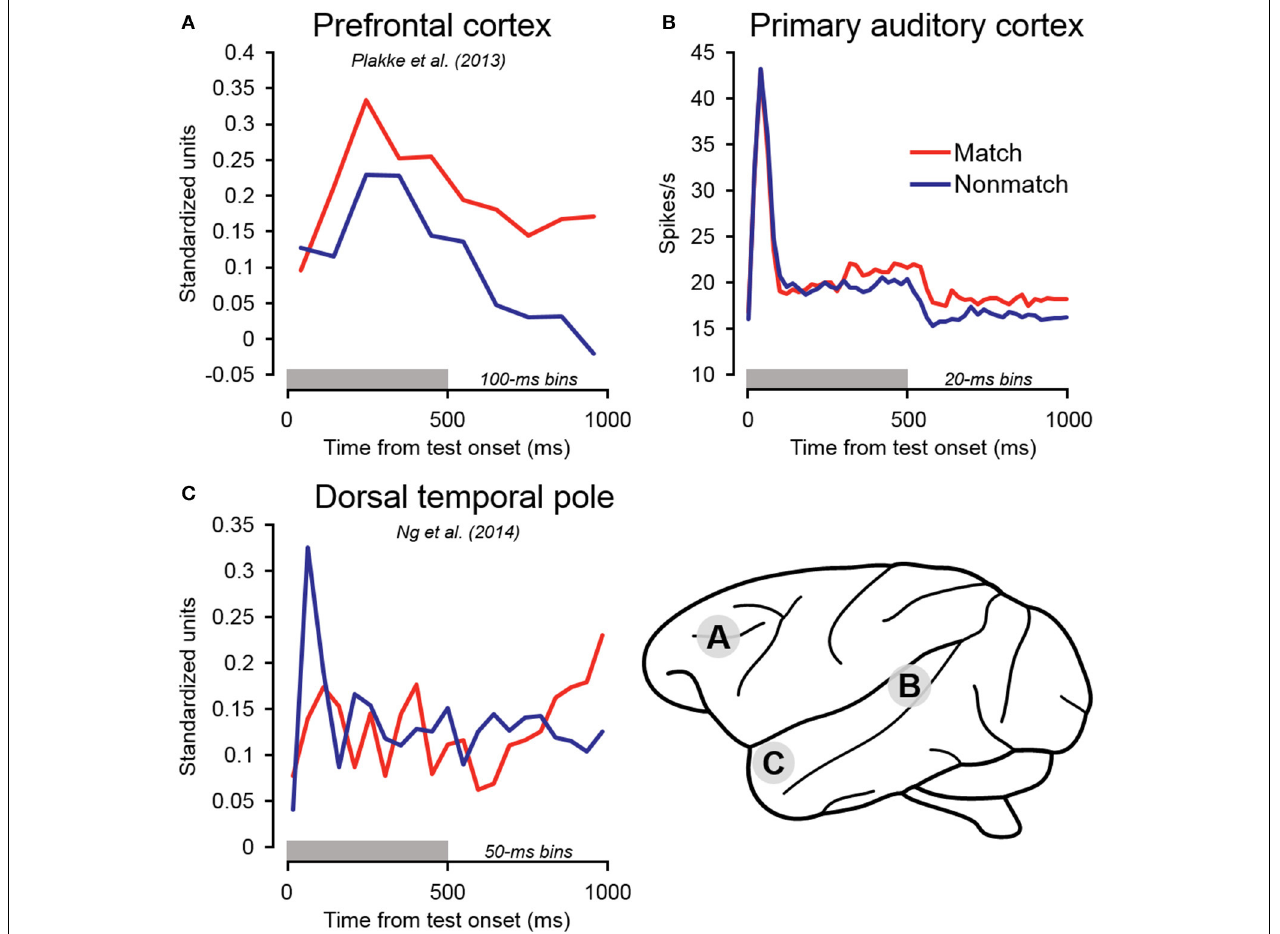
FIGURE 8 | Summary of population-averaged neurophysiological activity in three cortical areas for matching and non-matching test sounds. (A) In PFC, firing rates on match trials became elevated relative to non-match trials during the early sound presentation period. Elevated firing rates were similarly observed on match trials in (B) primary auditory cortex and (C) dorsal temporal pole. However, these effects occurred later than in PFC, during the sound period or cue offset period, consistent with the notion that elevated firing in these areas may reflect top–down feedback originating in PFC. In contrast to these late match enhancement